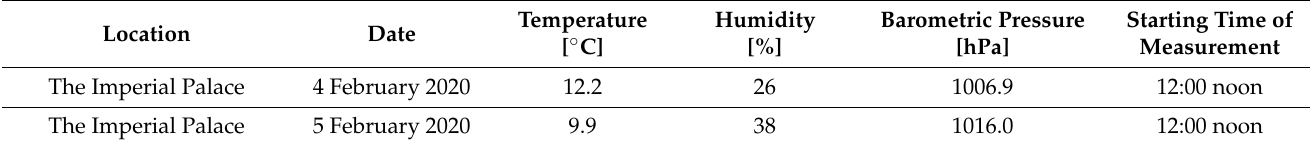
Table 2. Environmental conditions of measurement location in winter experiment.